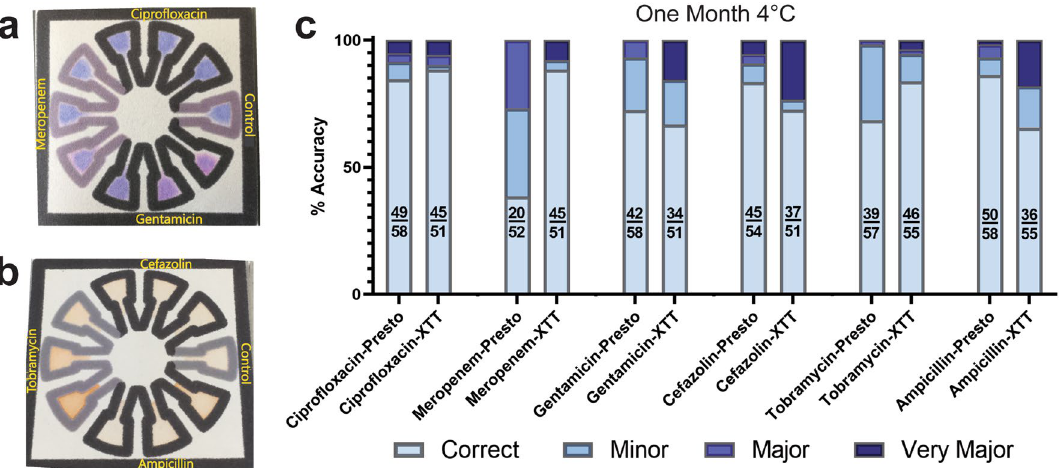
Figure 3. Shelf-life testing for 1 week and 1 month. ( a ) PrestoBlue with ciprofloxacin, meropenem, and gentamicin after 1 month at room temperature but before any bacterial loading. ( b ) XTT with cefazolin, tobramycin, and ampicillin after 1 month at room temperature but before any bacterial loading. ( c ) Ciprofloxacin, meropenem, gentamicin, cefazolin, tobramycin, and ampicillin results after 1 month of storage at 4 °C Fractions represent number of correct samples over number of total